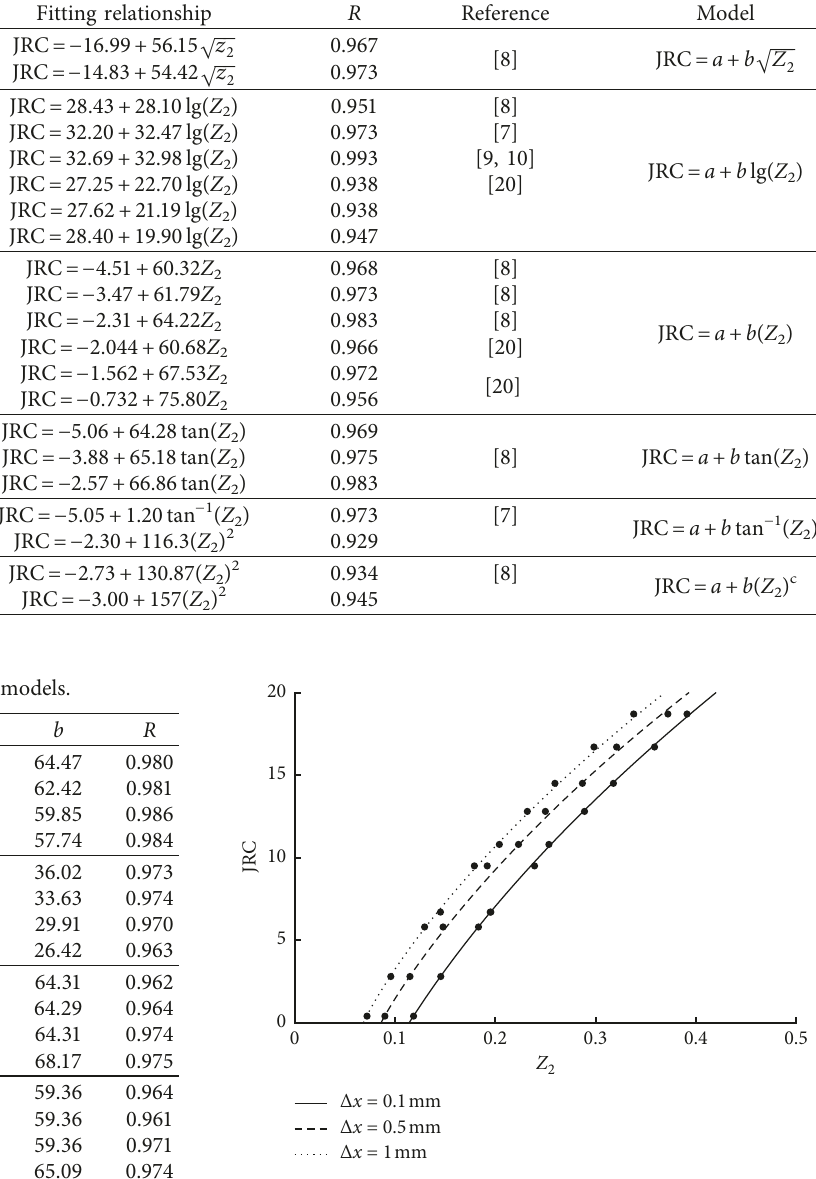
2 at different Δ x